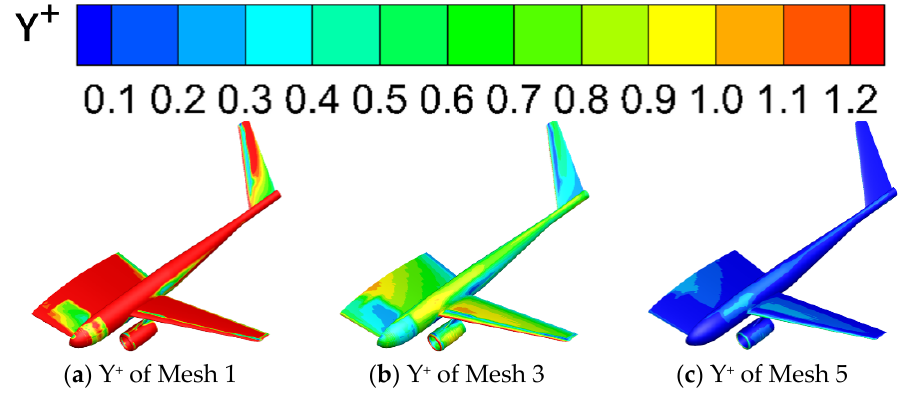
Figure 5. Y + of grid independence verification.